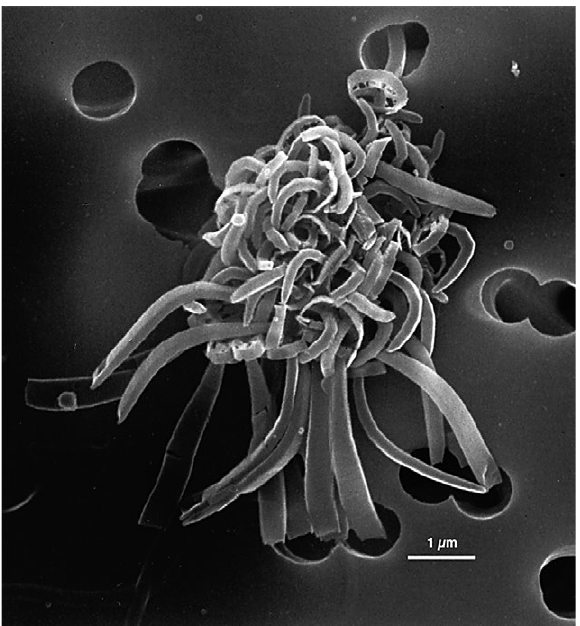
Fig. 1. – The new coccolithophorid Picarola margalefii dedicated to Ramon Margalef (Cros and Estrada 2004), symbol of the Margalef Award for Ecology established by the Government of Catalonia in